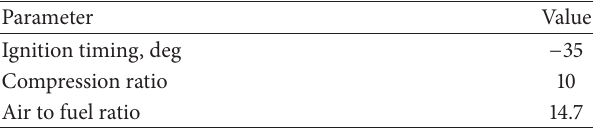
Table 4: Input parameters for reference test.